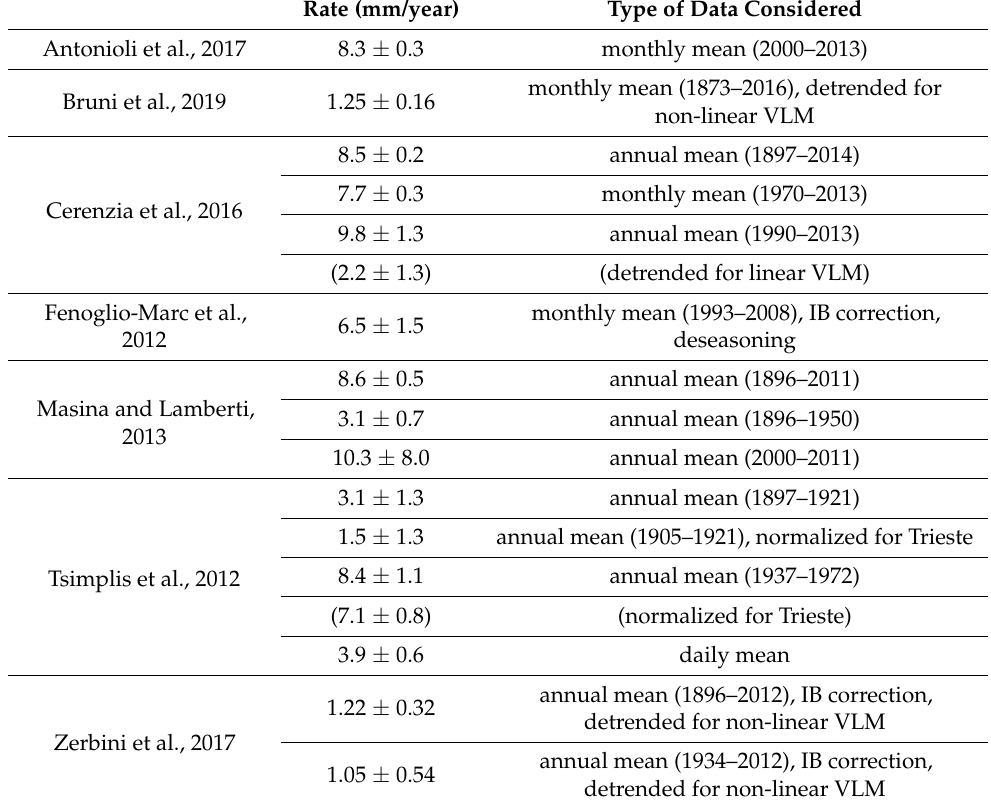
Table A1. Linear sea-level trend estimates (and related corrections applied) from some of the most representative studies conducted on the Marina di Ravenna TG time series. Time frames considered by various authors are indicated in